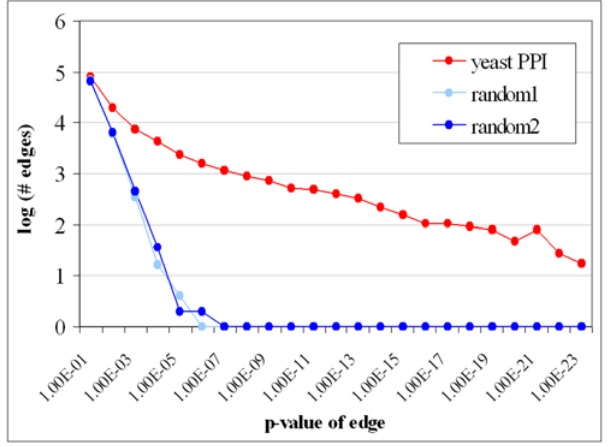
Figure 6. Log-log plot of the number of pairs of linked processes, as a function of the p-value of the link (PPI-Links, S. cerevisiae). Both types of random annotations yield far fewer pairs with very low p-values than the actual